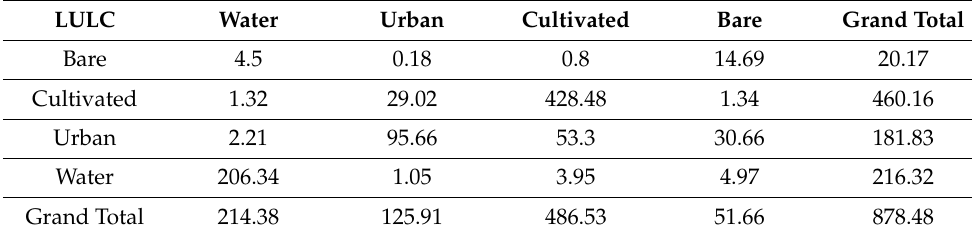
Table 7. Transition of LU/LC (km 2 ) from 2011–2021.